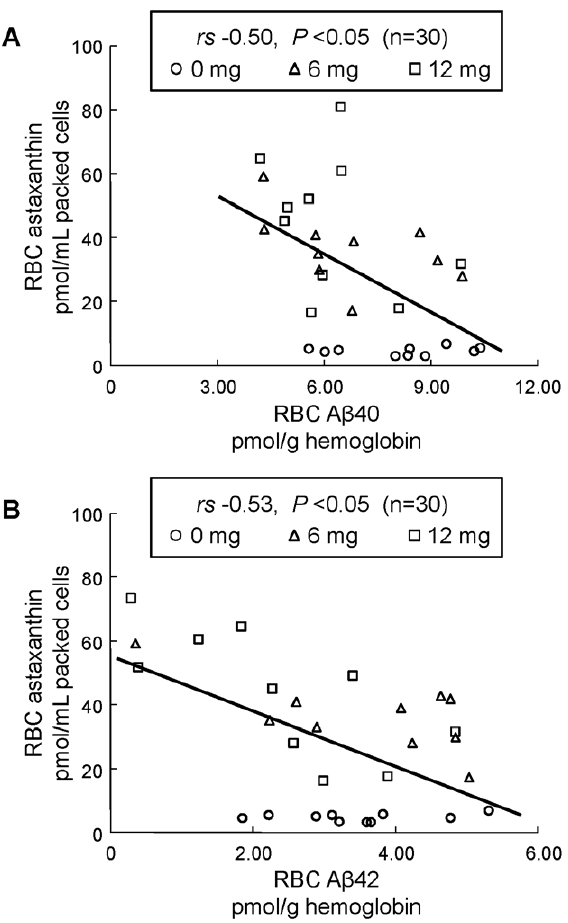
Means 6 SE are shown. Significantly different between young healthy volunteers and senior subjects: * P , 0.01.